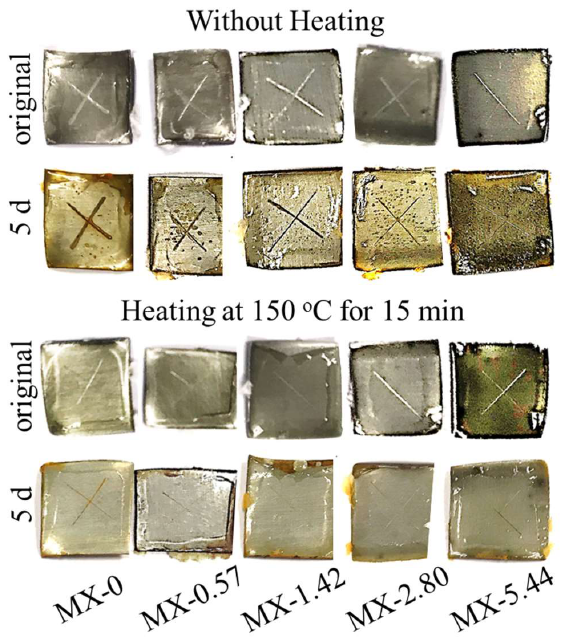
Figure 7. Photographs of MX-0–MX-5.44 coatings on tinplate before and after immersing in 3.5 wt % NaCl solution for 5 d.